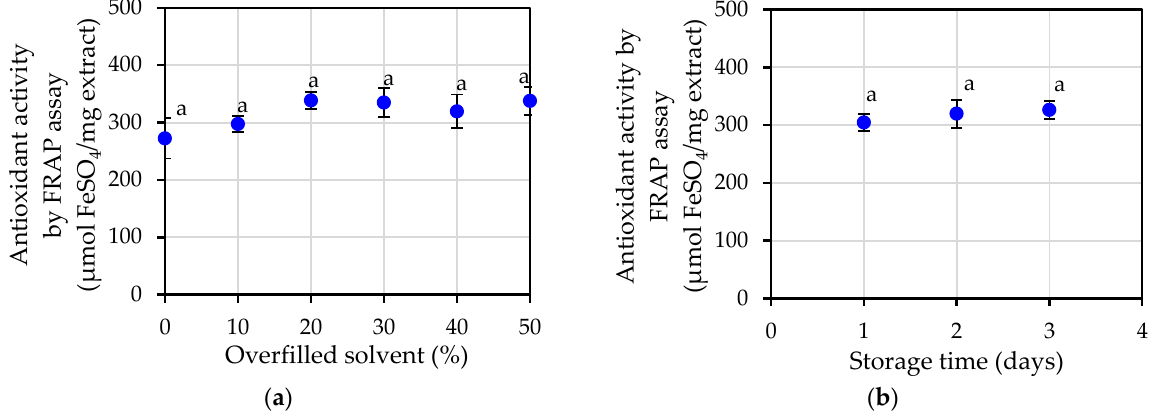
Figure 5. Antioxidant activity by FRAP assays of jasmine essential oil: ( a ) at varying percentage of overfilled solvent; ( b ) at varying storage time. The same letters a in the same figure indicate that values are not significantly different ( p < 0.05).